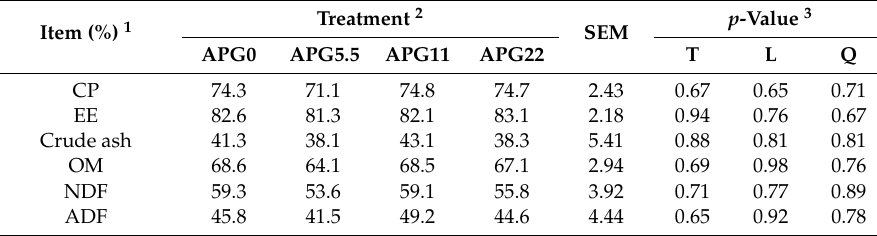
Table 4. E ff ects of APG supplementation on digestibility in lactating